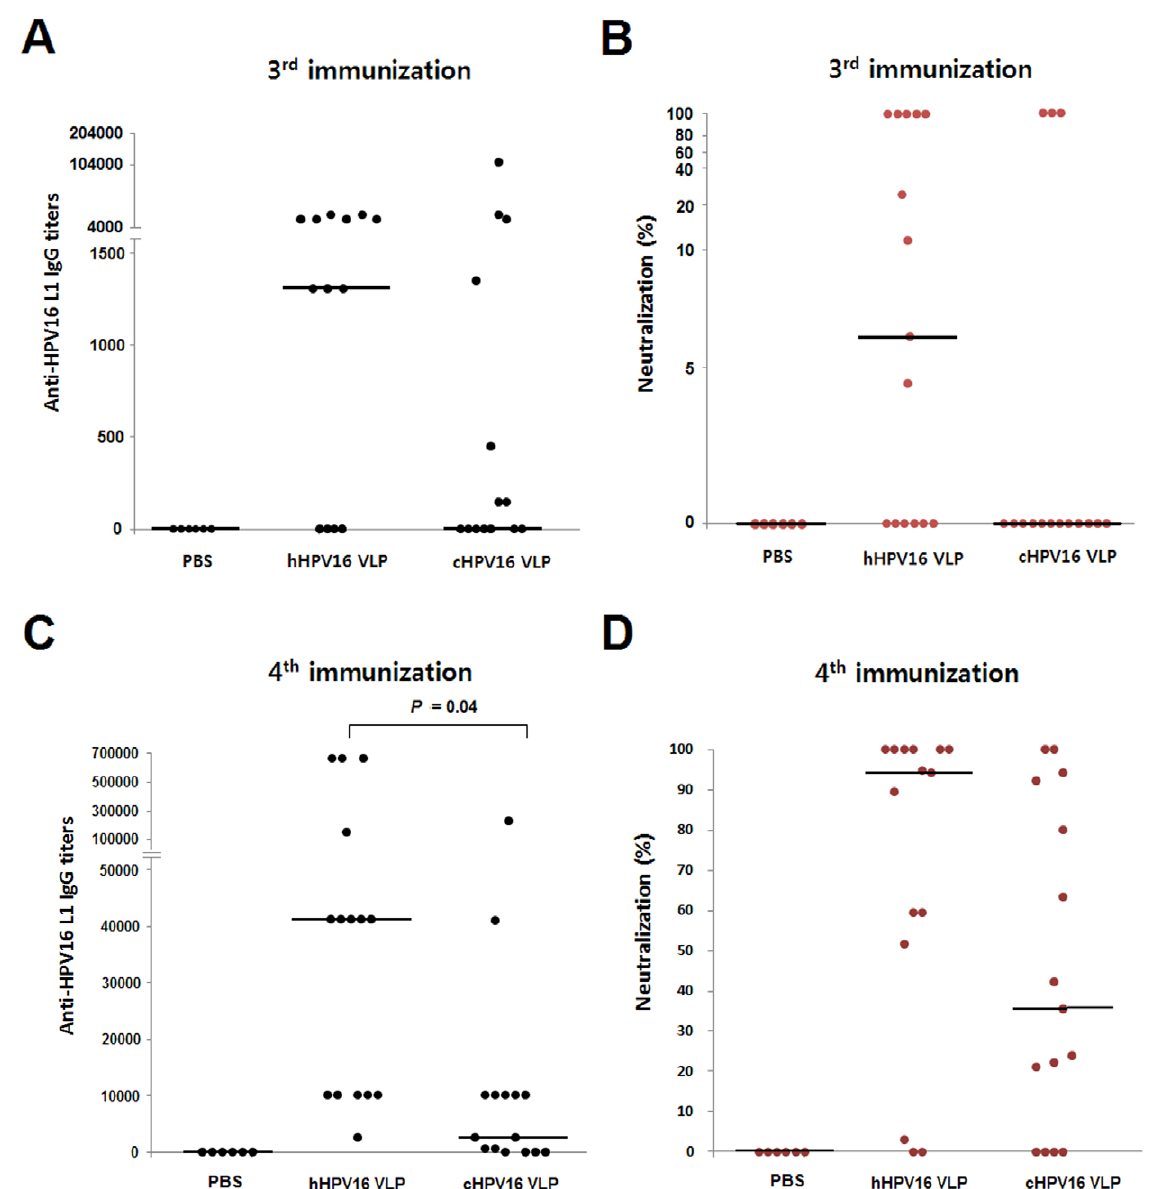
Figure 5. Immunization Protocol-1 Anti-HPV16 L1 IgG titer and neutralization activity resulting. Mice were immunized according to immunization protocol-1 (Table 2). The mice were immunized four times with 100 m l of PBS, 8 ng of hHPV16 VLP or 8 ng of cHPV16 VLP at two-week intervals, in the absence of adjuvant. Ten days after the 3 rd and 4 th immunization, the mice sera were obtained and analyzed. Panels A and B present the anti-HPV16 L1 IgG titer and neutralization activity after the 3 rd immunization, respectively. Panels C and D present the anti-HPV16 L1 IgG titer and neutralization activity after the 4 th immunization, respectively. The horizontal bars are median values of the IgG titer and neutralization activity (PBS, n=6; hHPV16 VLP, n=15; cHPV16 VLP,